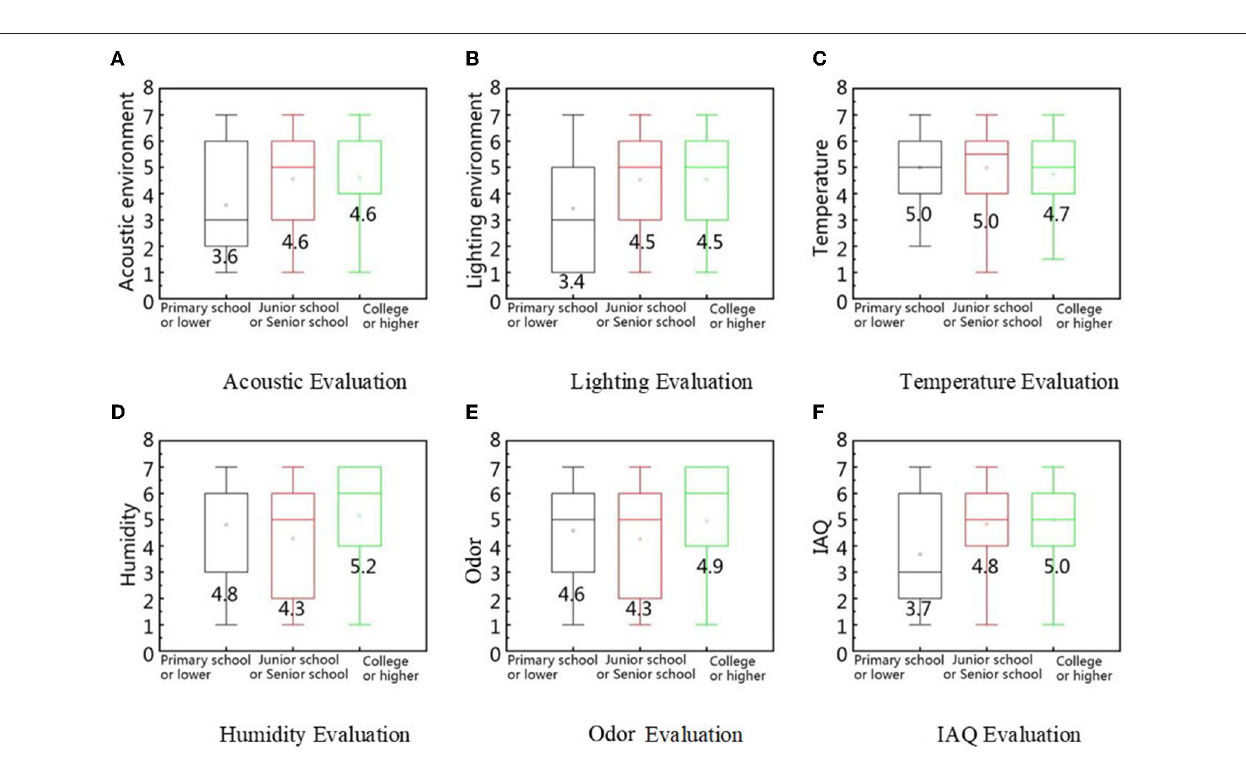
Frontiers in Public Health |